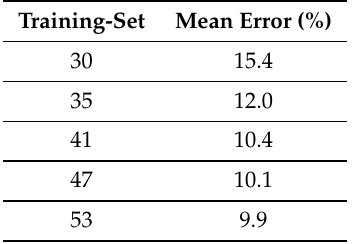
Figure 3. Evolution of the stress at break with: ( top-left ) Exit flow rate; ( top-right ) PP-g-MA/TS ratio; ( middle-left ) Ratio TS; ( middle-right ) Rotation speed; ( bottom-left ) Temperature; and ( bottom-right ) TS dispersed. Table 5. Mean error for different numbers of points in the